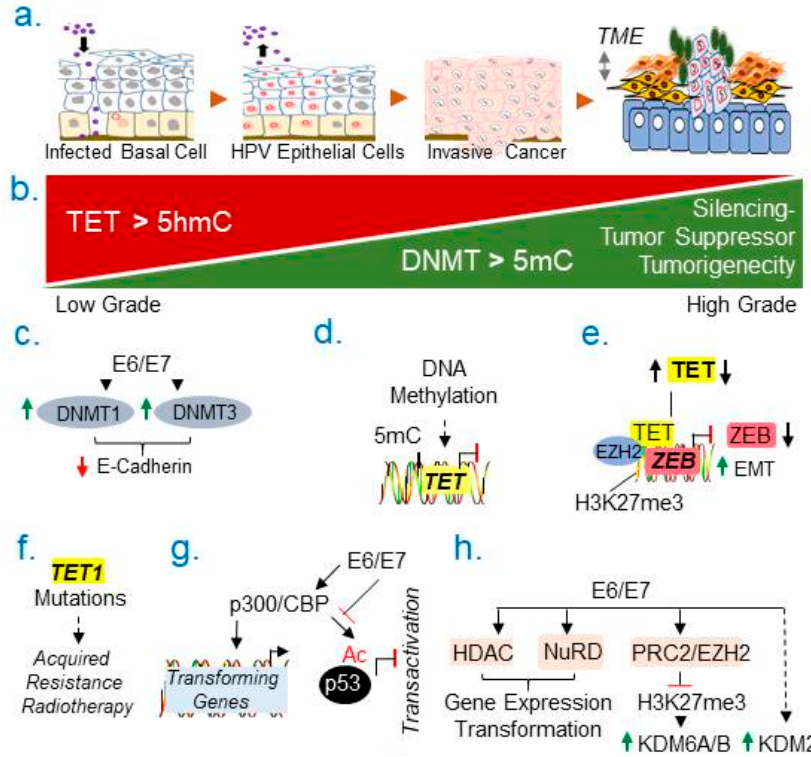
Figure 7. Epigenetic regulation of cervical cancer development. ( a ) Illustrations showing HPV-driven cervical cancer development and interaction with tumor microenvironment (TME). See Supplementary Figure 1 for description of TME. ( b ) Reduced levels of TETs and 5hmC and increased levels of DNMT and 5mC in cervical cancer. ( c ) Regulation of DNMT expression by E6/E7 oncoproteins. ( d ) Regulation of TET expression by DNA methylation pathway. ( e ) TET regulation of EMT via modifying the expression of EMT master regulator ZEB1. ( f ) Potential role of TET1 mutations in acquired resistance to radiotherapy. ( g ) E6/E7 regulation of target gene expression via modifying the activity of HATs and p53 acetylation. ( h ) E6/E7 regulation of gene expression via HDACs, NuRD complexes, and PRC2/EZH2 complexes.